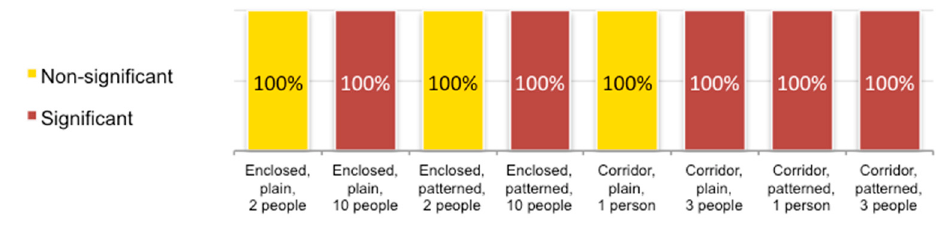
Figure 7. Percentage of participants with significant/non-significant size variations for each space in major perception filter.